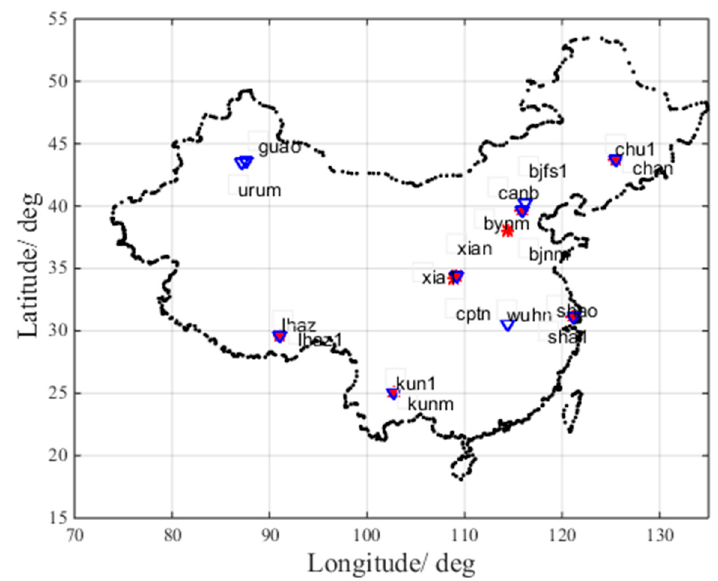
Figure 3. Locations of eight International GNSS Monitoring Assessment System (iGMAS) stations and 10 International GNSS Service (IGS) stations in China.